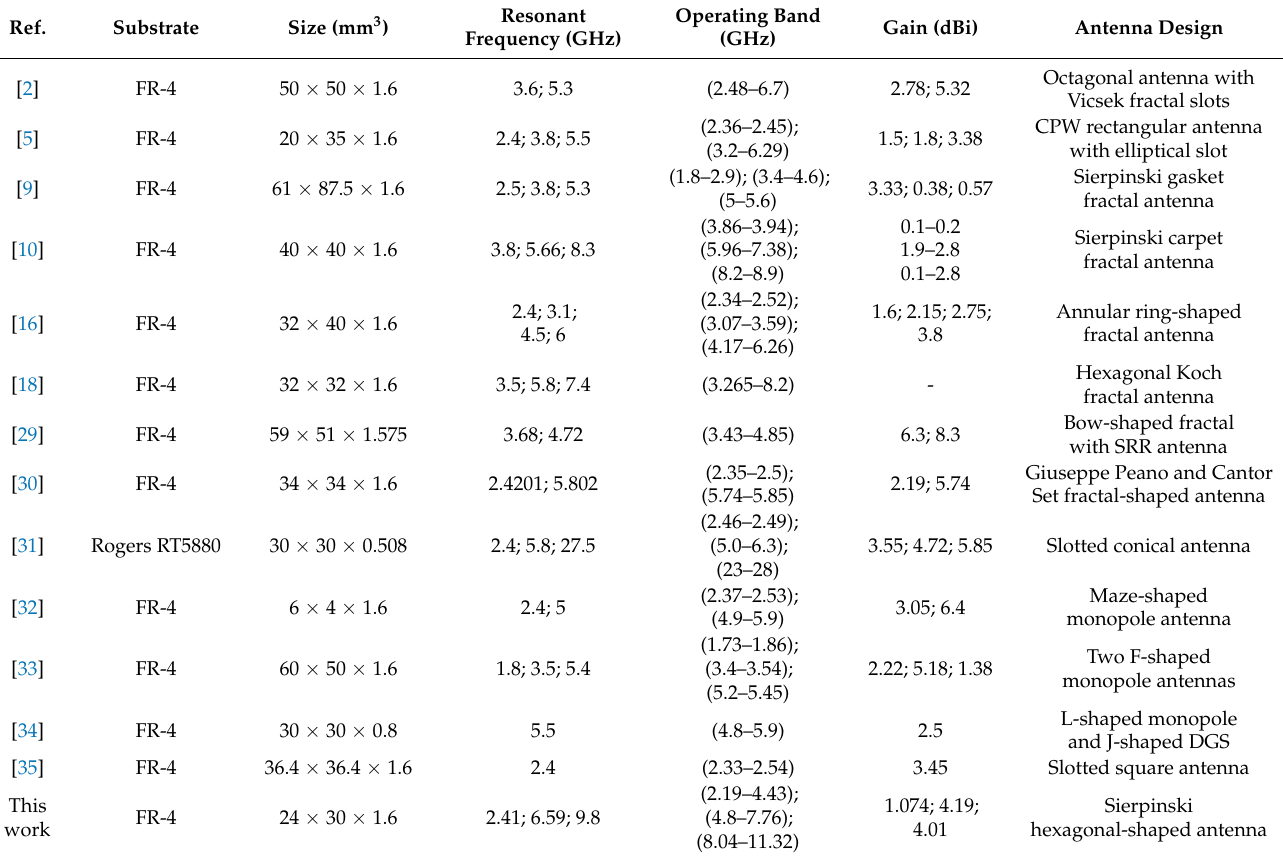
Table 4. Comparison with previously released research